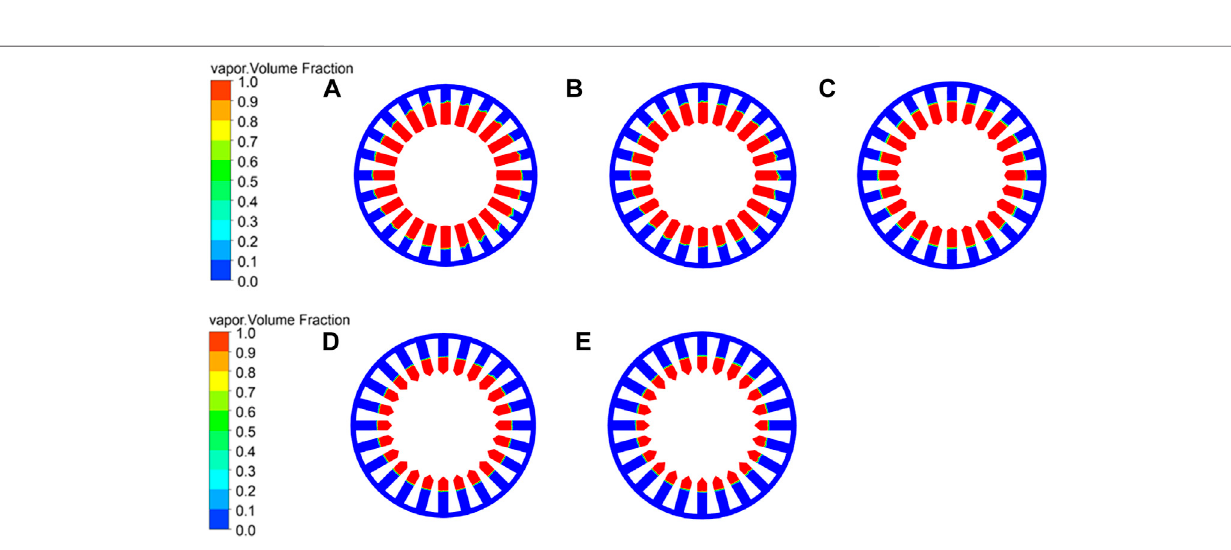
FIGURE 10 | Vapor phase distribution with different cone bottom lengths: (A) L 1 = 1 mm, (B) L 2 = 3 mm, (C) L 3 = 5 mm, (D) L 4 = 7 mm, and (E) L 5 = 9 mm.